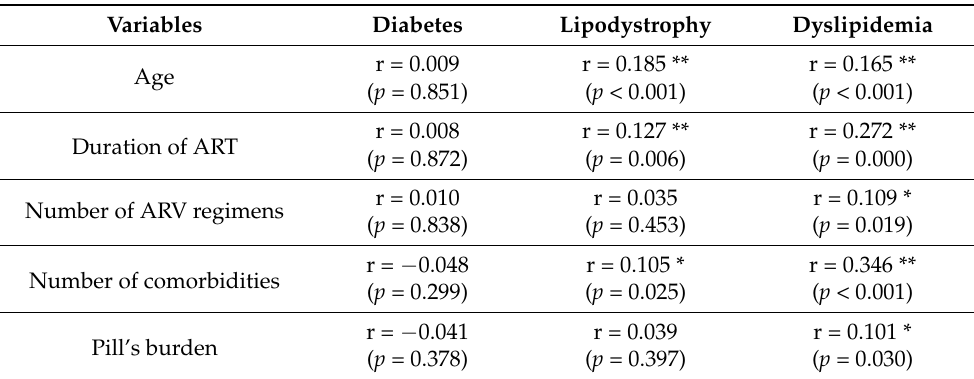
Table 6. Pearson correlation on the risk of developing lipodystrophy or dyslipidemia for all the patients (N =